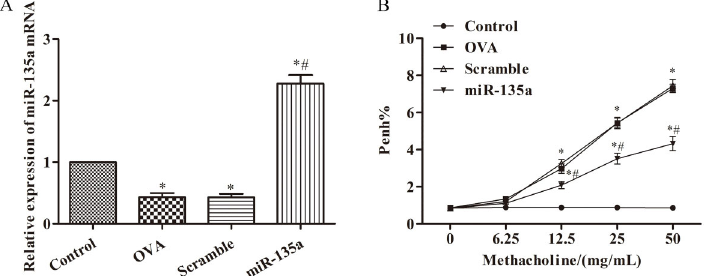
Figure 1. Expression of miR-135a in mouse lung tissue and its effect on airway hyperresponsiveness in mice. A , RT-PCR was used to detect the content of miR-135a mRNA in mouse lung tissue of different groups; ( B ), effect of miR-135a on airway hyperresponsiveness (Penh%) in mice of different groups. Data are reported as means ± SD. *P o 0.05 compared to the control group; # P o 0.05 compared to the ovalbumin (OVA) group